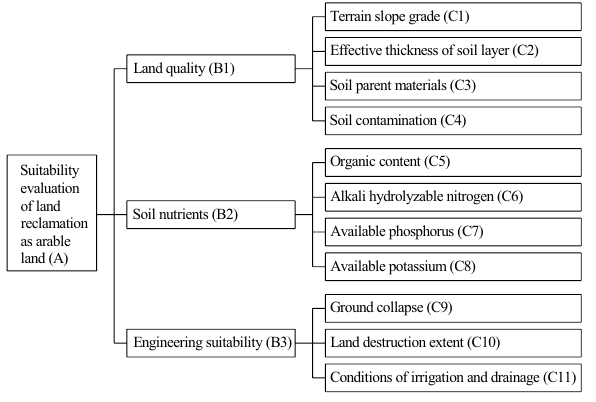
Fig. 2 The hierarchy of evaluation indicators for suitability evalua- tion of land reclamation as arable